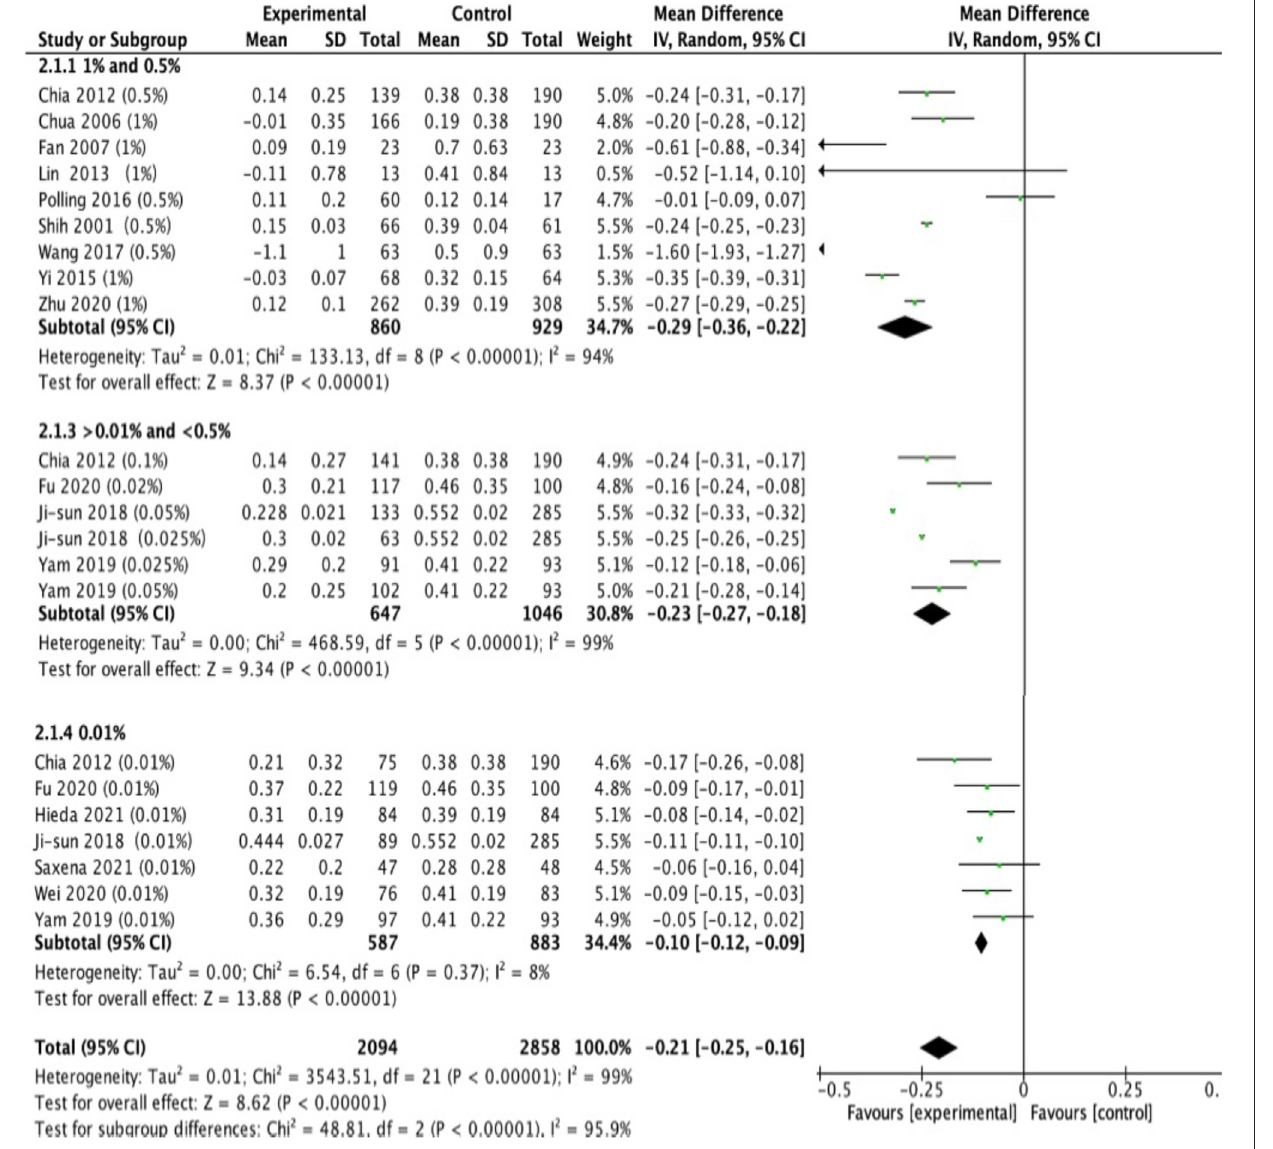
near vision [144 of 1,633 (7.5%)], and allergic reaction [49 of 1,387